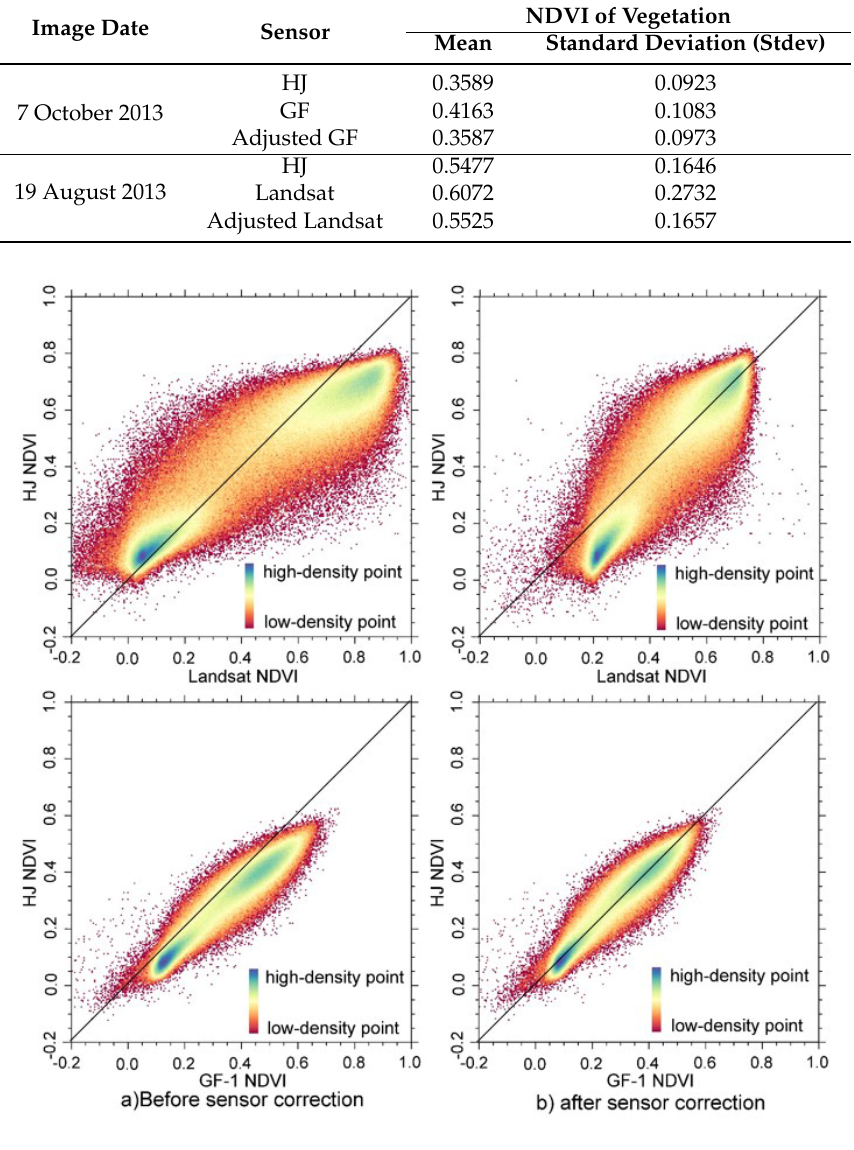
Figure 2. The scatter plot comparisons of Landsat Normalized Different Vegetation Index (NDVI) data, Gaofen satellite no. 1 wide field-of-view camera (GF-1 WFV) NDVI, and Huanjing satellite (HJ) NDVI data ( a ) before and ( b ) after sensor